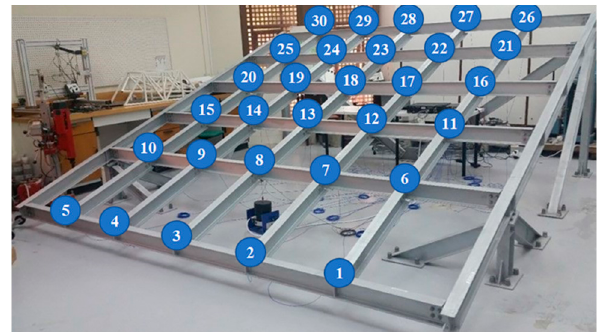
Figure 7. The main steel frame of the QU grandstand simulator [27].